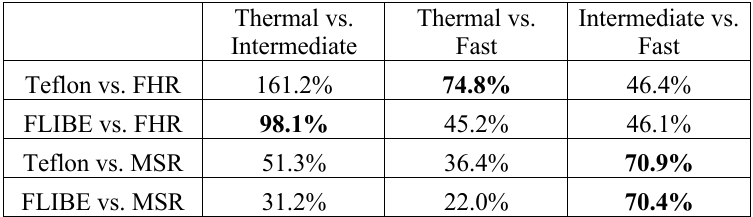
Table II. Comparison of the different insertions’ similarity . Thermal